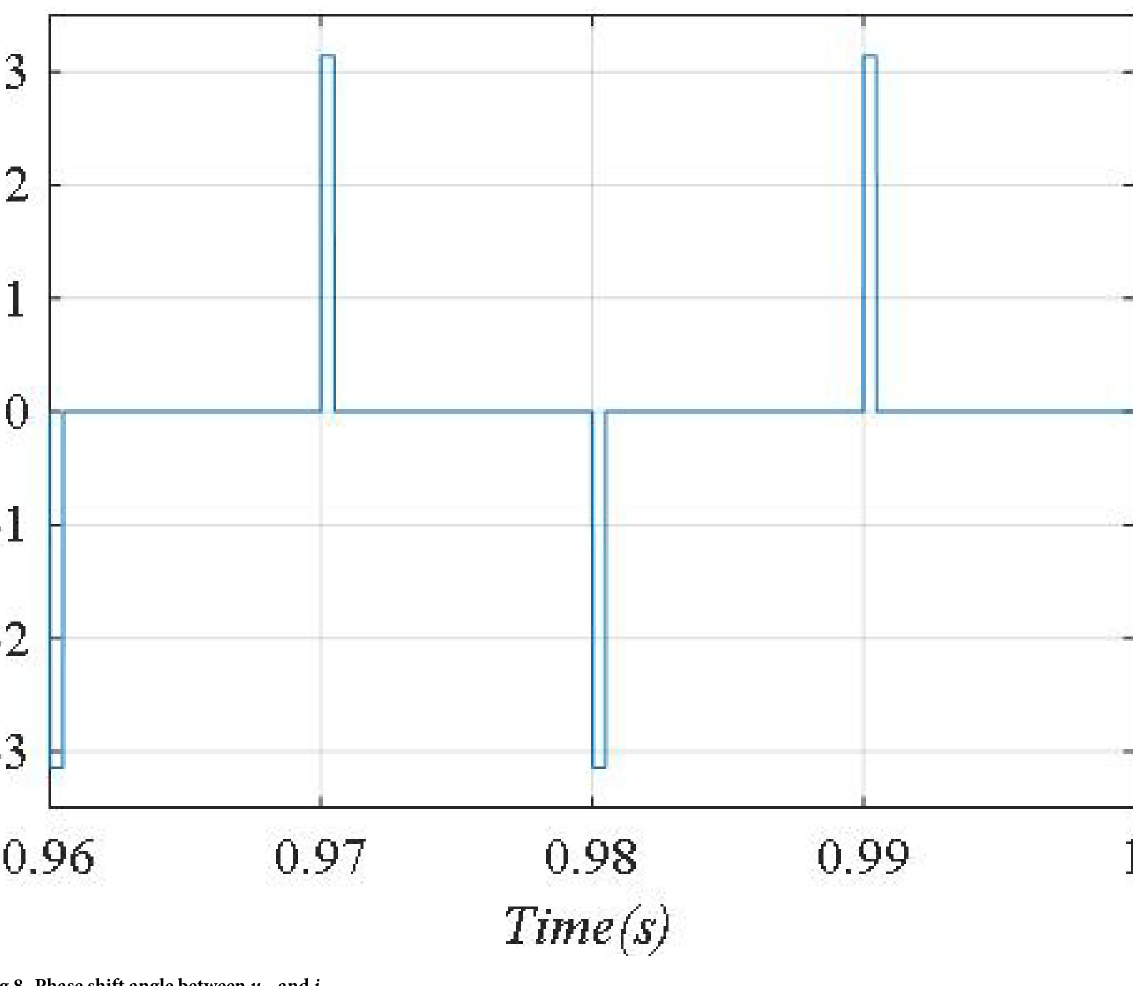
Fig 8. Phase shift angle between u sa and i sa